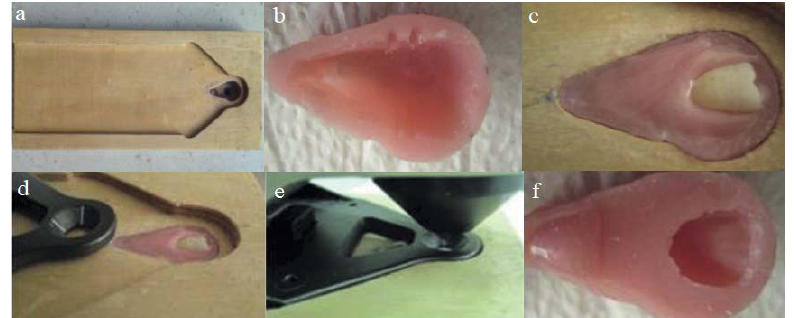
Figure 1. Preparation of the stabilizer plate and acrylic resin blocks for colorimetry. ( a ) Wooden stabilizer plate with a socket for an acrylic resin block. ( b ) Acrylic resin block carved with retention grooves. ( c ) Tooth positioned in the acrylic resin block for colorimetric measurement. ( d , e ) Adjustment of the colorimeter on middle third of the tooth. ( f ) The acrylic resin block following removal of the tooth.